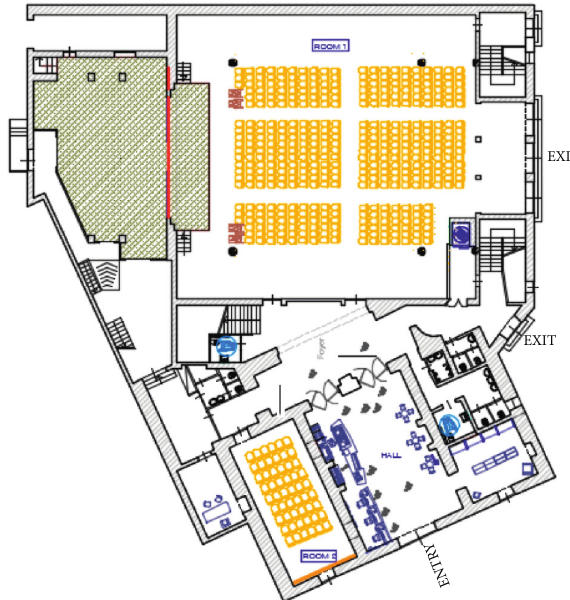
Figure 9: Ground floor